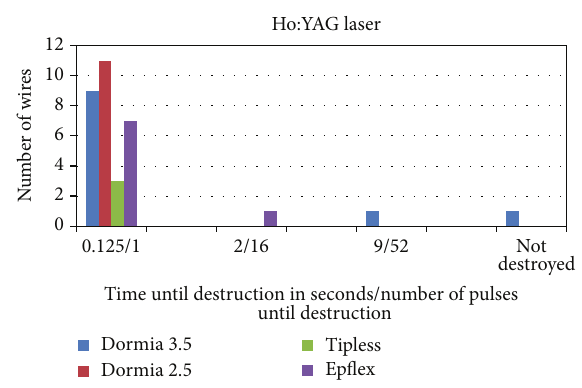
Figure 8: The Hol:YAG laser destroyed all baskets wires with the exception of one 3.5 F Dormia basket. The destruction took place from 1 to 9 sec/from 1 to 52 pulses mostly after one